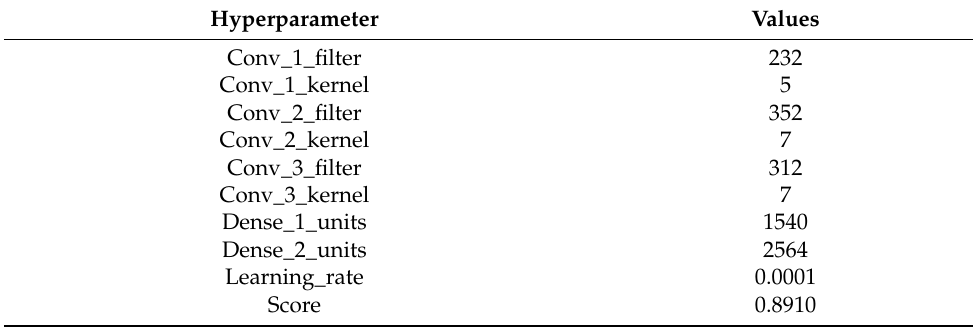
Table 2. Summary of AlexNet Models hyperparameter search result (Best Trials).